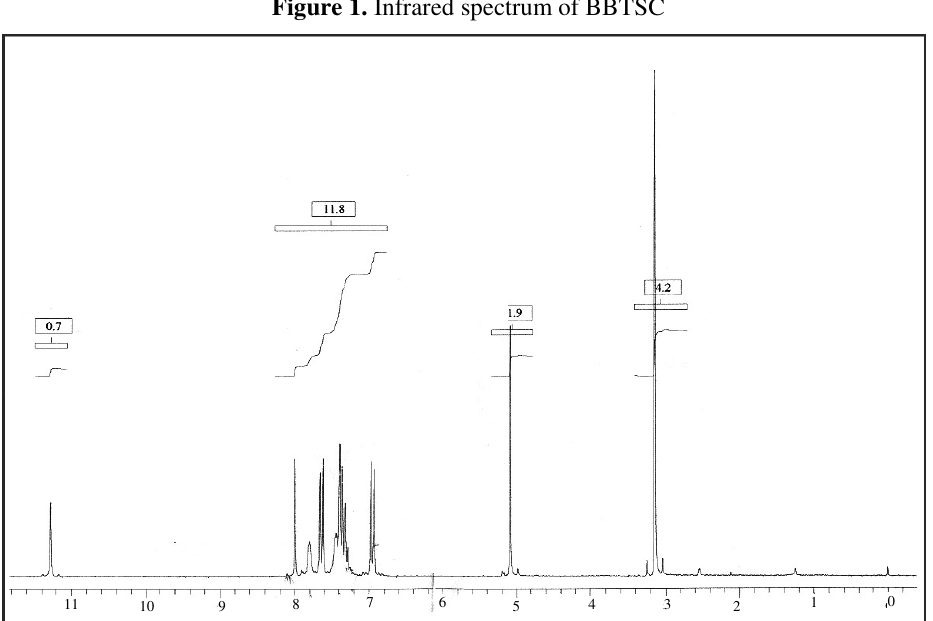
Figure 2. 1 H NMR spectrum of